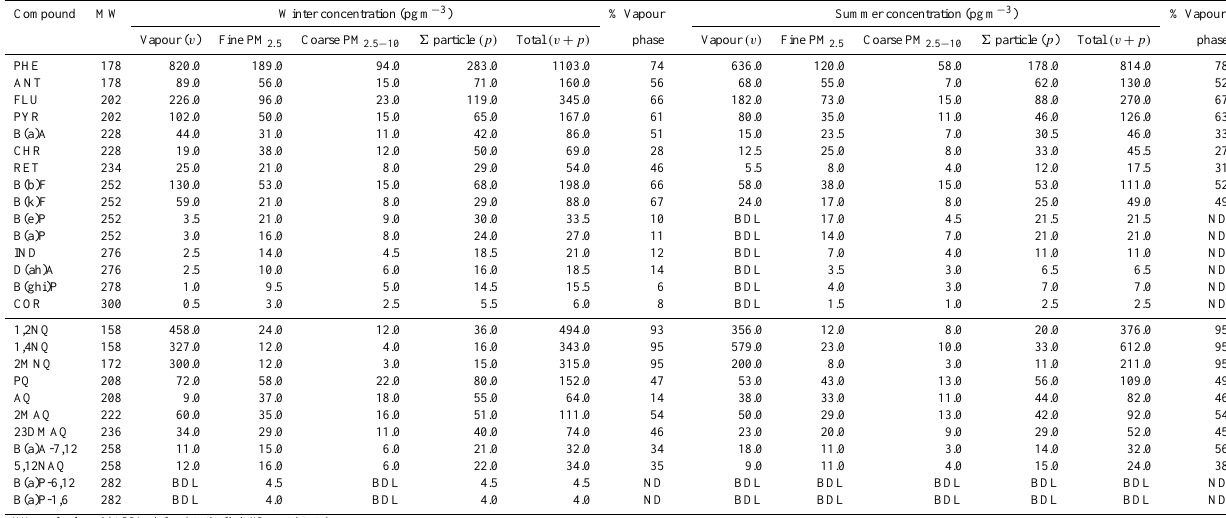
Table 1. Vapour and particulate phase concentrations of PAH and quinone compounds during summer and winter seasons. Compound MW Winterconcentration(pgm − 3 ) %Vapour Summerconcentration(pgm − 3